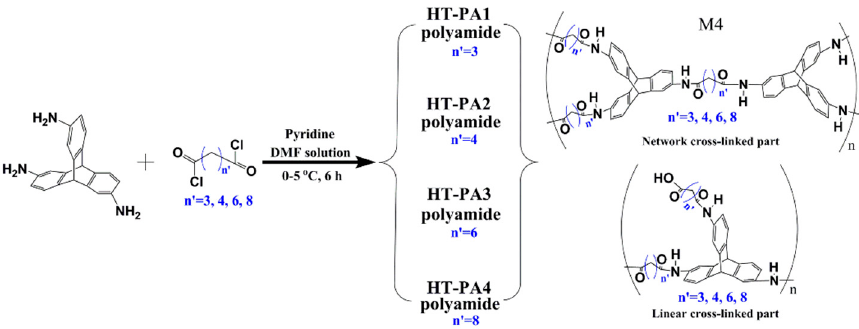
Figure 10. Synthesis of triptycene-based polyamides by solution polymerization. Reproduced from Reference [71].